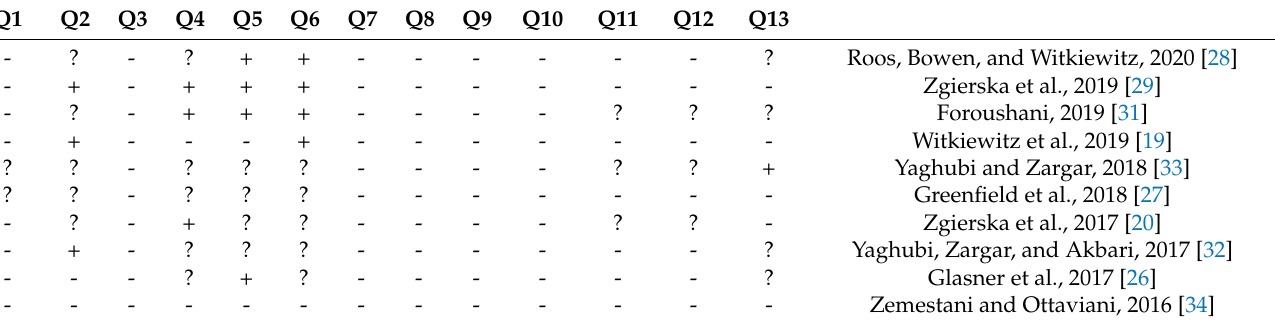
Table A4. Evaluation of methodological quality of included randomized controlled trials.